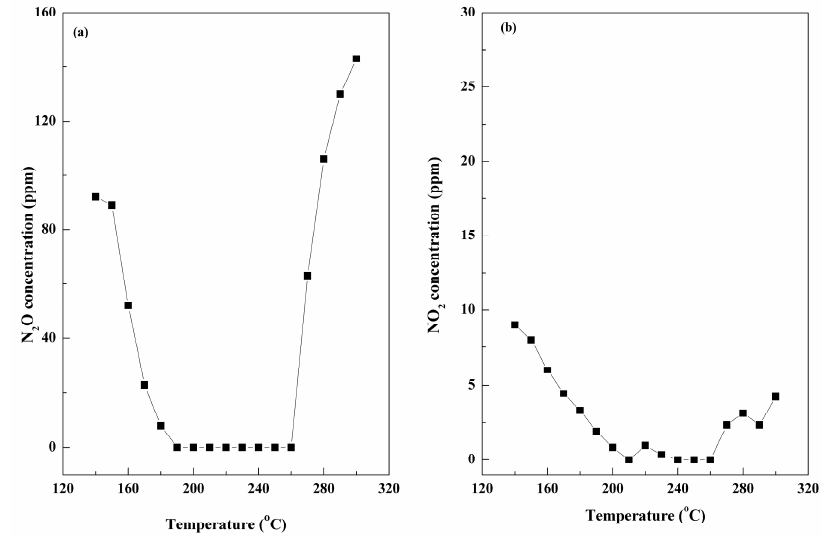
Figure 7. The N 2 O output concentration ( a ), NO 2 output concentration ( b ) over Ce-Mn-Fe/GO-20%.